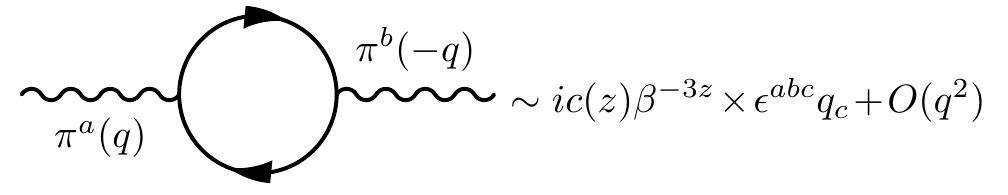
Figure 1 . One-loop computation of the Hall contribution to the anisotropic momentum